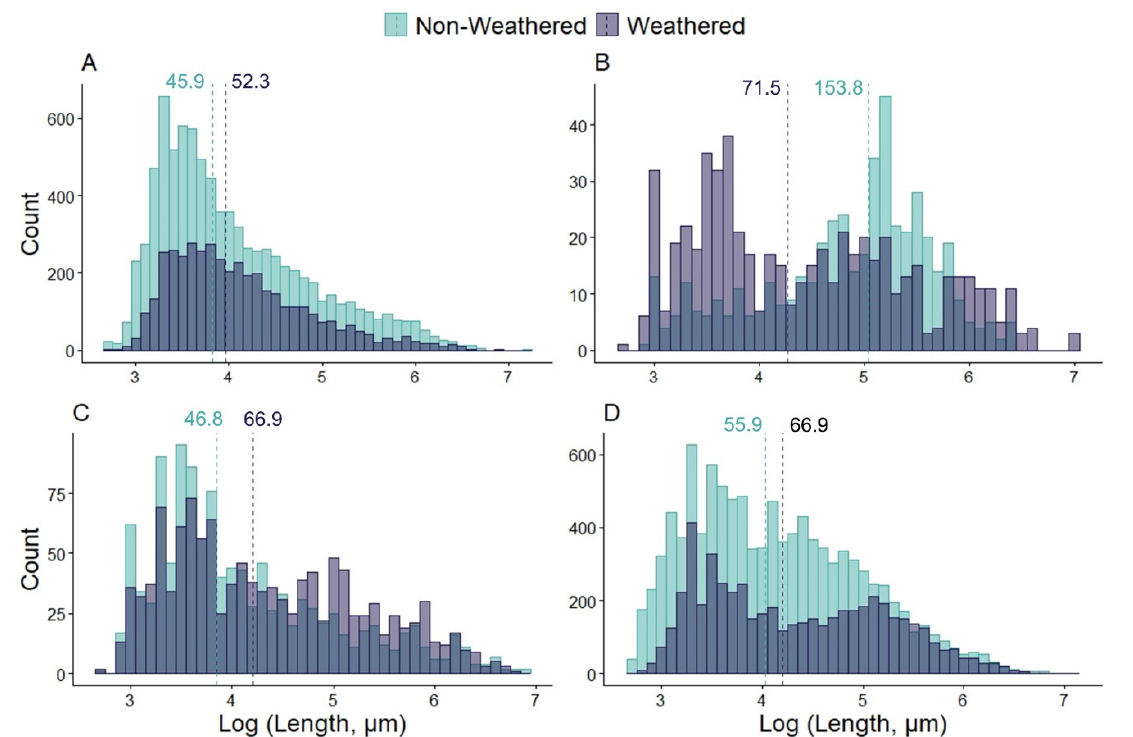
Figure 1. Distribution of the length of non-weathered and weathered paint mix ( A ), zinc paint ( B ), tire particle (TP) ( C ) and PVC ( D ) microparticles applied in the growth inhibition tests. The size of the bins was 0.1 on a logarithmic scale. The length is defined as the maximum Feret diameter, and the median values in micrometres are denoted.